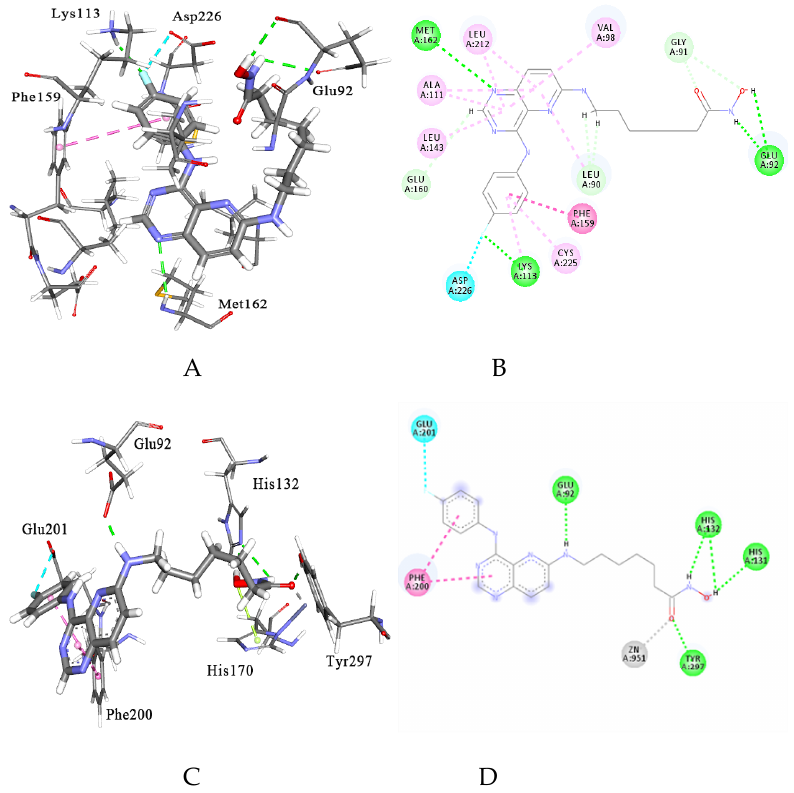
Figure 5. The predicted binding mode of compound A12 with Mnk2(2hw7, A and B , binding energy: −177.95 kcal/mol) and HDAC1(1c3s, C and D , binding energy: −238.47 kcal/mol). The hydrogen bond interaction are colored in green.